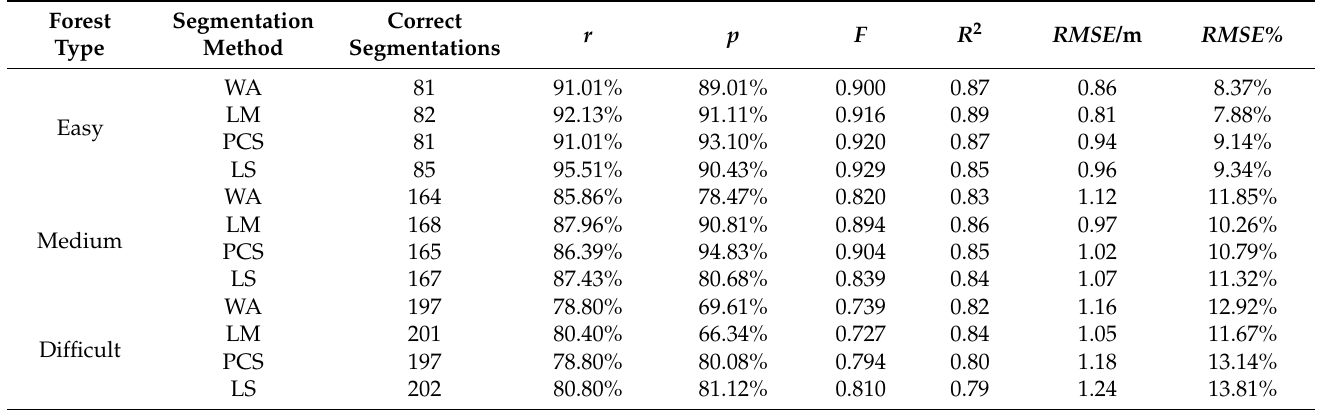
Table 2. Comparison of the Tree Height Extraction Accuracies Achieved with Different Segmentation